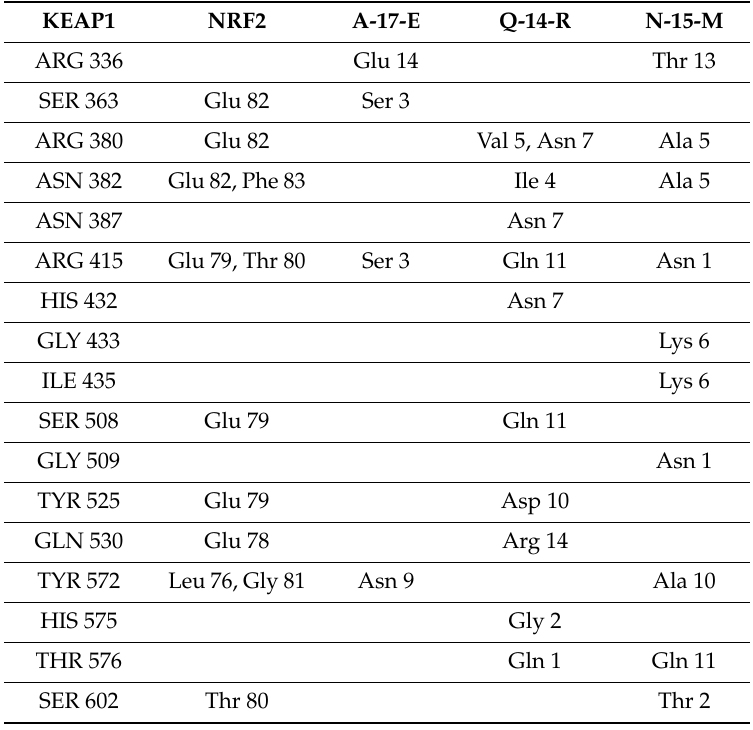
Table 4. Residues involved in the binding of Keap1 with Nrf2 or the analyzed